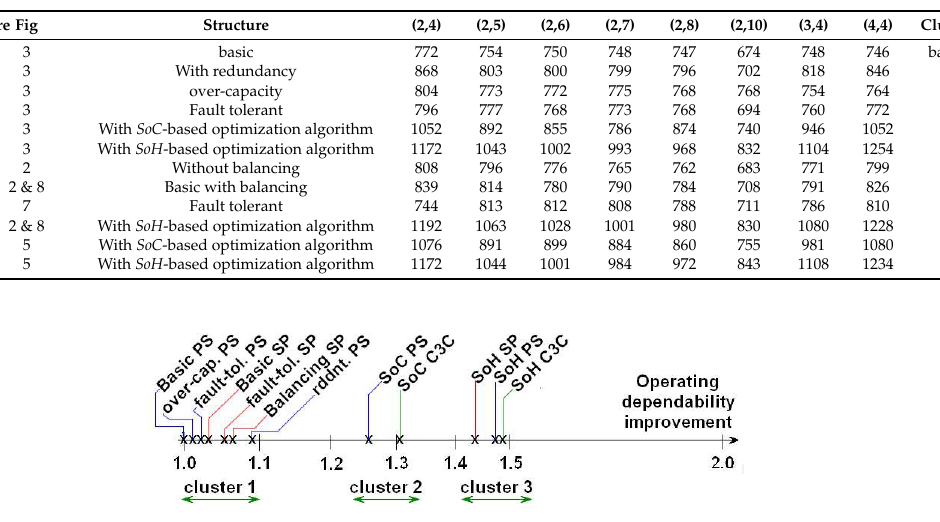
Figure 11. Example of simulation result ( SoC , SoH , OCV , Q 0 ) for a C3C architecture with variant SoH -based optimization algorithm: ( a ) SoC ; ( b ) SoH ; ( c ) OCV , in Volts; ( d ) Q 0 , in Ah. Table 2. Simulation results: operative dependability.